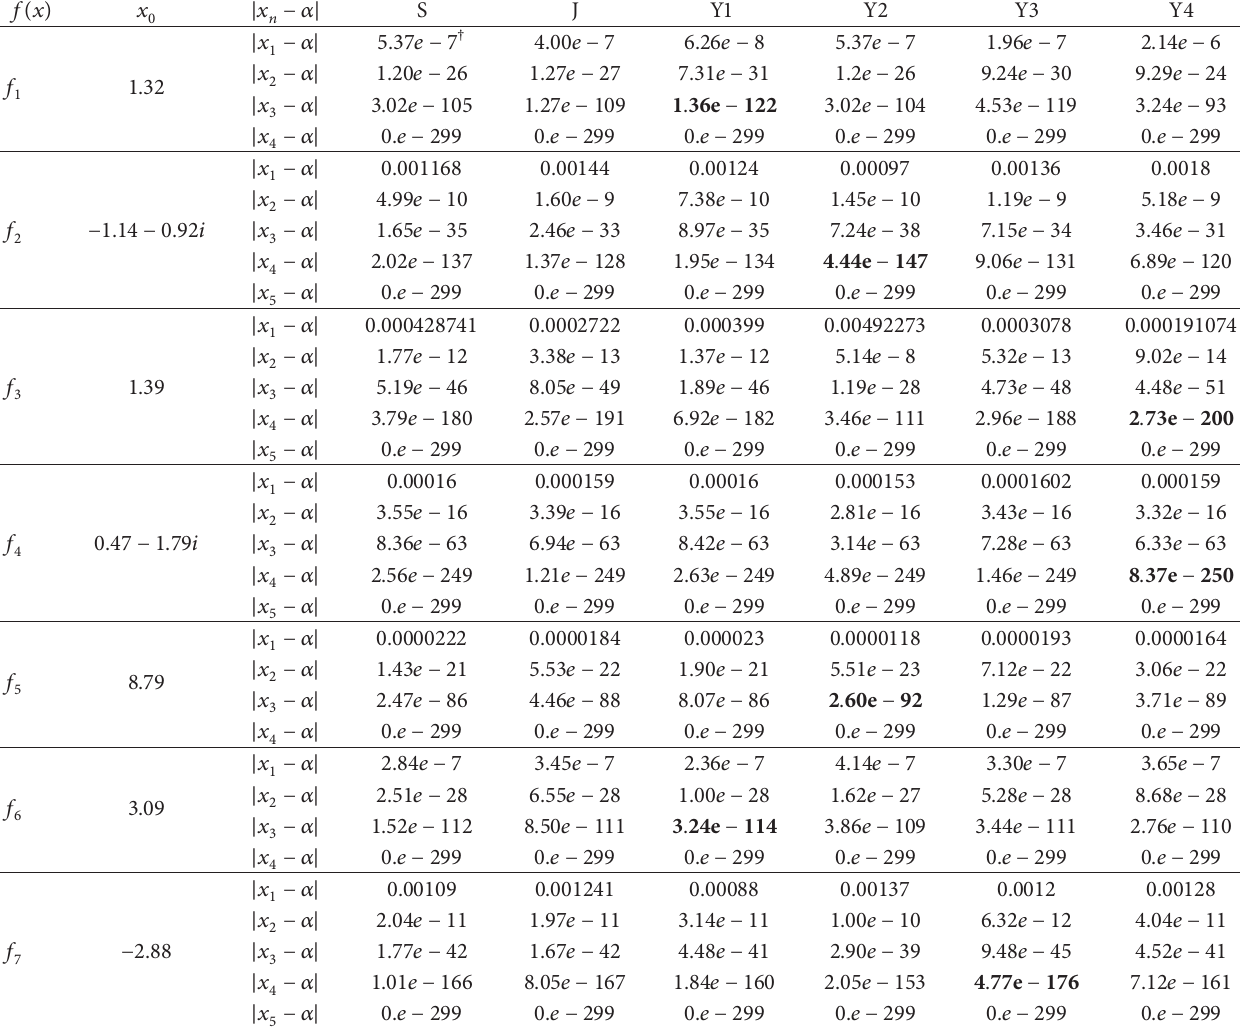
Table 5: Comparison of |𝑥 𝑛 − 𝛼| for high-order iterative